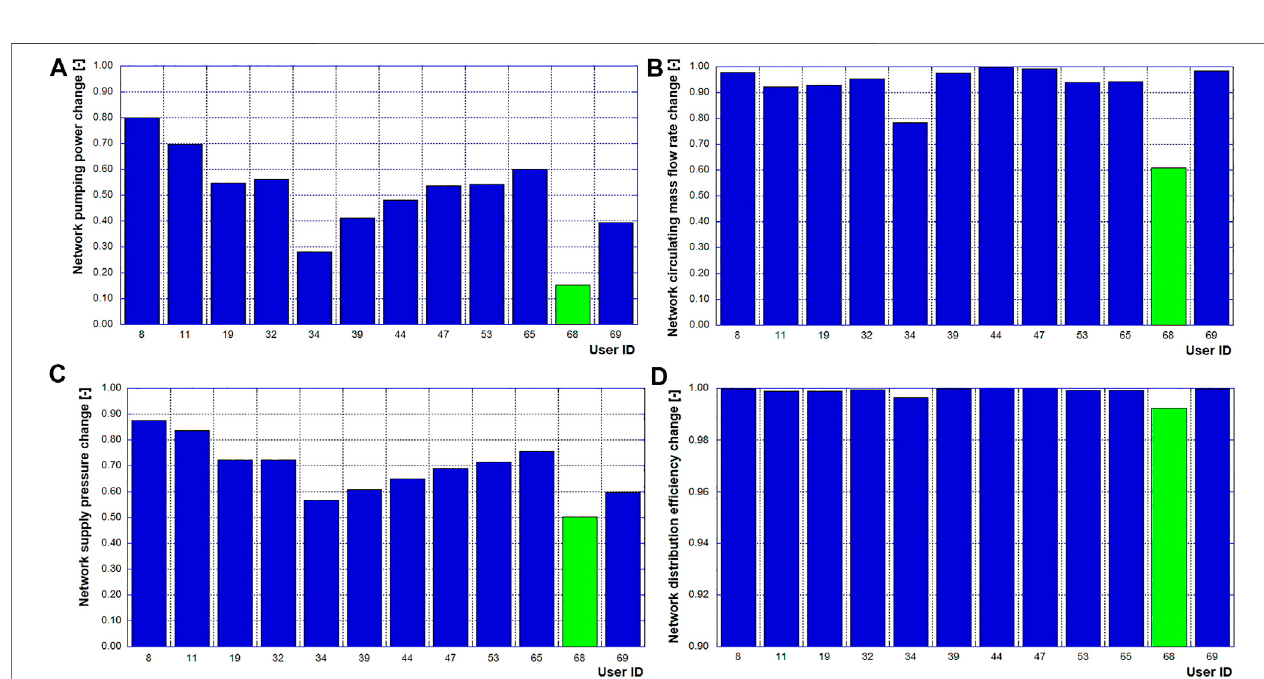
FIGURE 7 | Effect on the network of prosumer allocation: (A) pumping power change, (B) circulating mass fl ow rate, (C) supply pressure, and (D) distribution ef fi ciency.